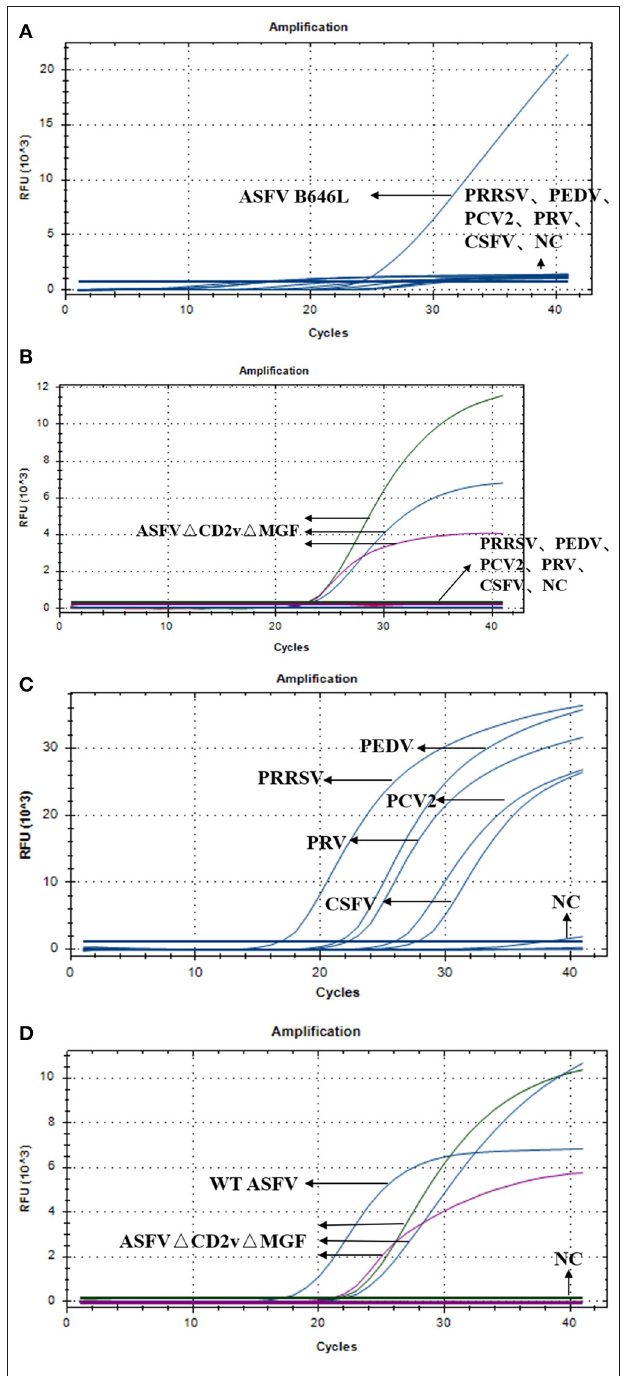
FIGURE 4 | (A) Amplification curves of ASFV, PRRSV, PEDV, PCV-2, PRV, CSFV, and NC. (B) Amplification curves of ASFV 1 CD2v 1 MGF, PRRSV, PEDV, PCV-2, PRV, CSFV, and NC. (C) Amplification curve of PRRSV, PEDV, PCV-2, PRV, CSFV, and NC. (D) Amplification curves of ASFV, ASFV 1 CD2v 1 MGF and